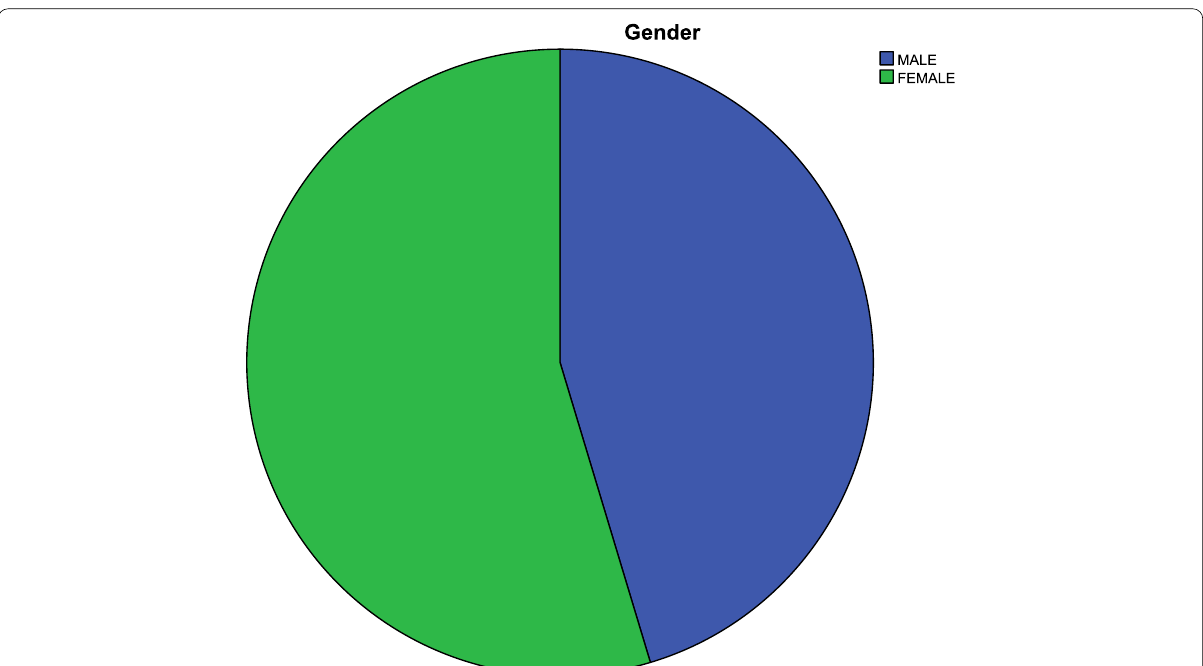
Fig. 3 Distribution of hemoglobinopathies among patients investigated at Aga Khan Hospital, Kisumu, and its satellite centers in Western Kenya based on gender